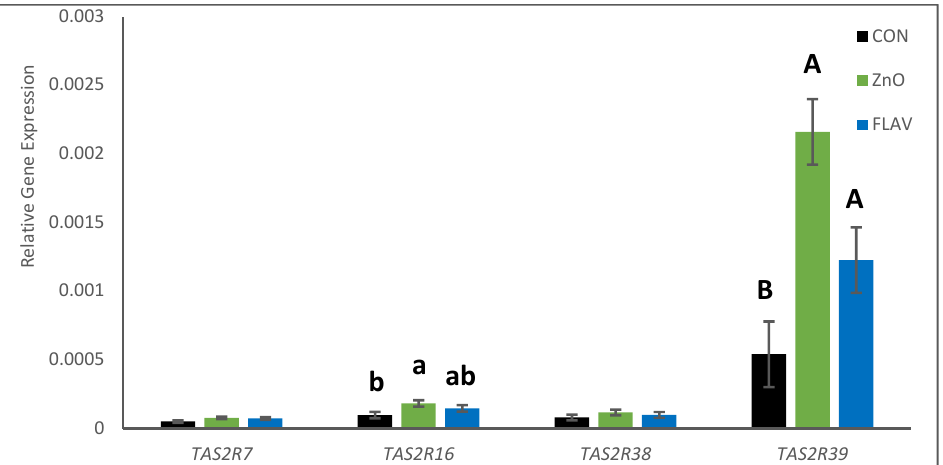
Figure 3. Gene expression of TAS2R on pigs fed the experimental diets analyzed by experimental diet. a, b means statistically different ( p < 0.05) within TAS2R16; A, B means statistically different ( p < 0.05) within TAS2R39.